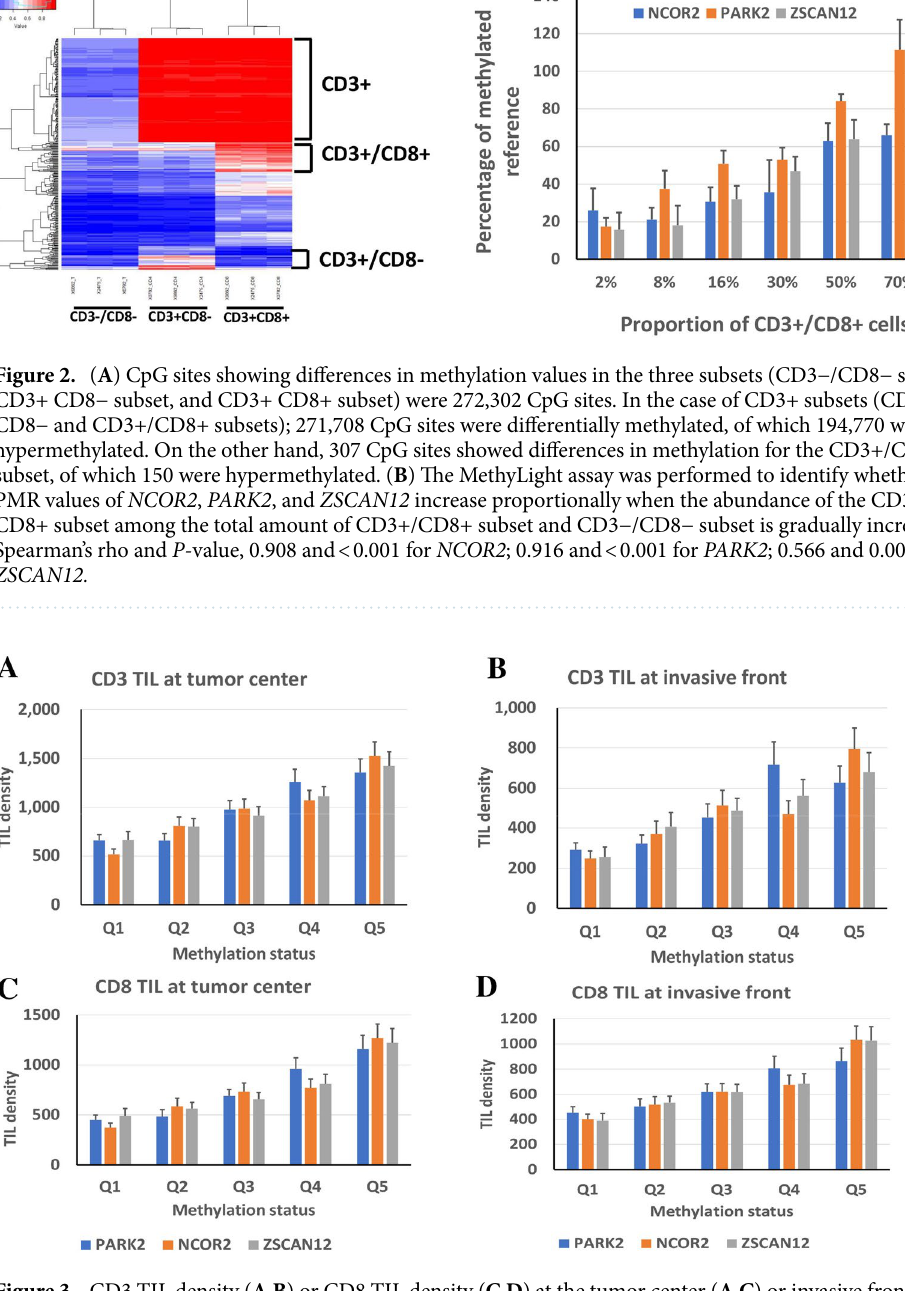
Figure 3. CD3 TIL density ( A , B ) or CD8 TIL density ( C , D ) at the tumor center ( A , C ) or invasive front ( B , D ) according to quintile subsets of NCOR2 , PARK2 , and ZSCAN12 . Spearman’s rho and P -value are summarized in Supplementary Table